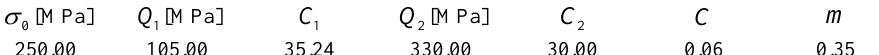
Table 1 . Johnson-Cook material constants for the S235JR low-alloy steel.